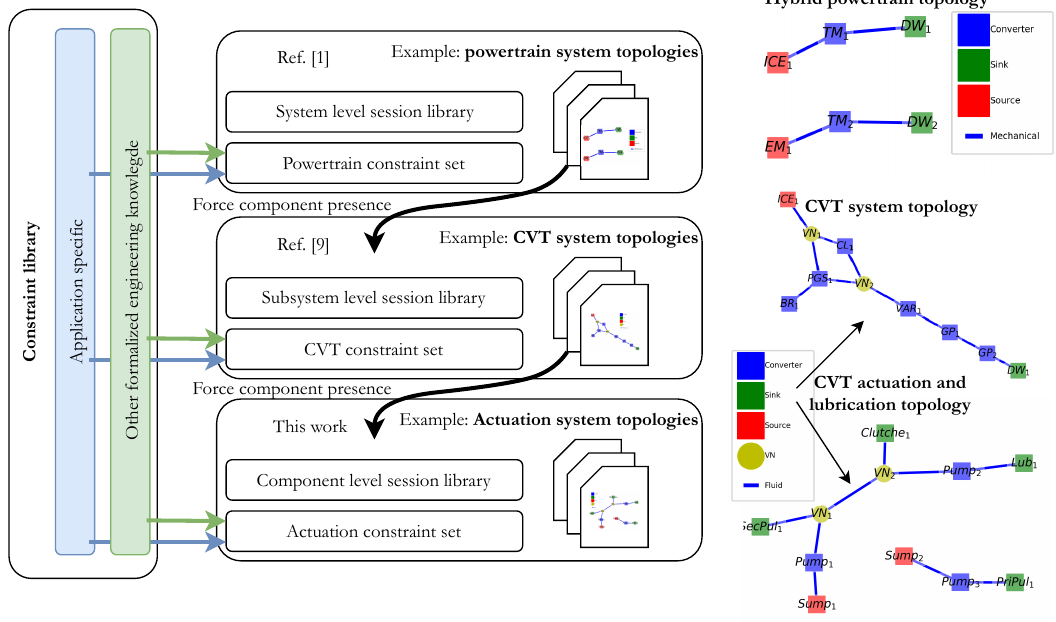
Figure 10. Schematic diagram of the multi-level topology generation process. Arbitrary example topologies are provided per system level. Related work is also